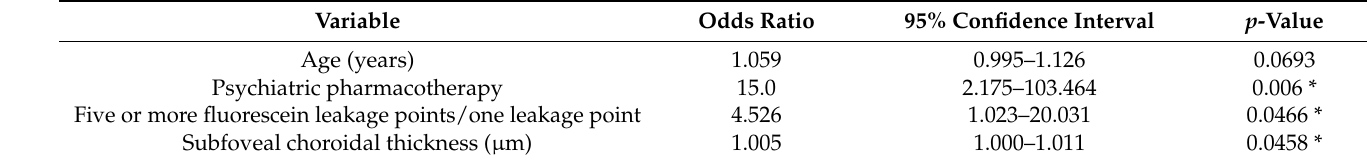
Table 2. Factors associated with low 5-HT